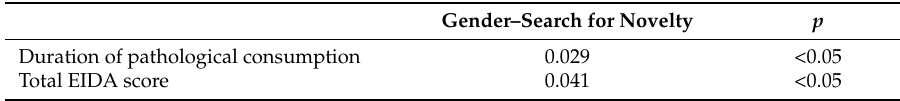
Table 8. Relationship of personality with the severity of the AUD accoing to Cloninger. This was influenced by gender in a statistically significant